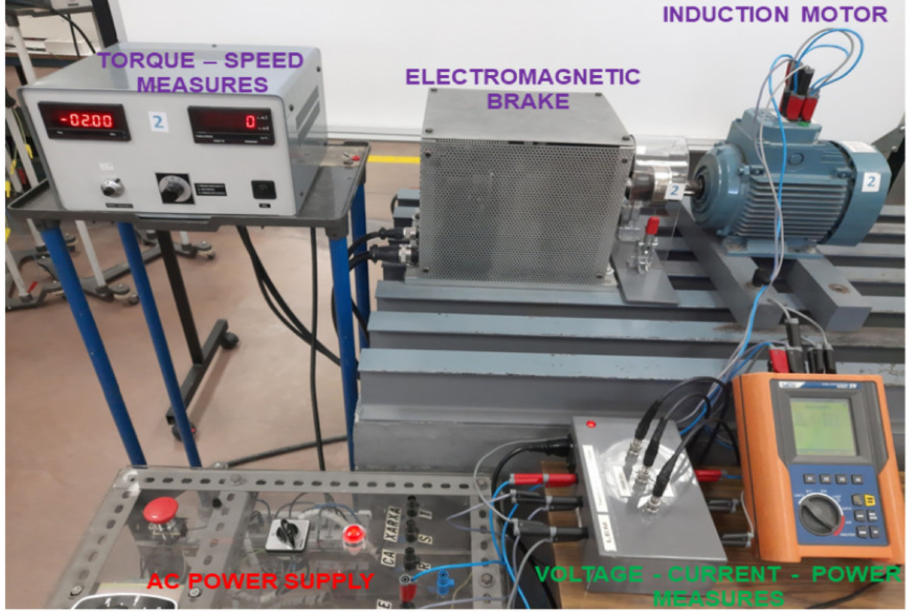
Figure A1. Test bench performed in the laboratory. Table A1. Laboratory tests result on the 1.5 kW motor.